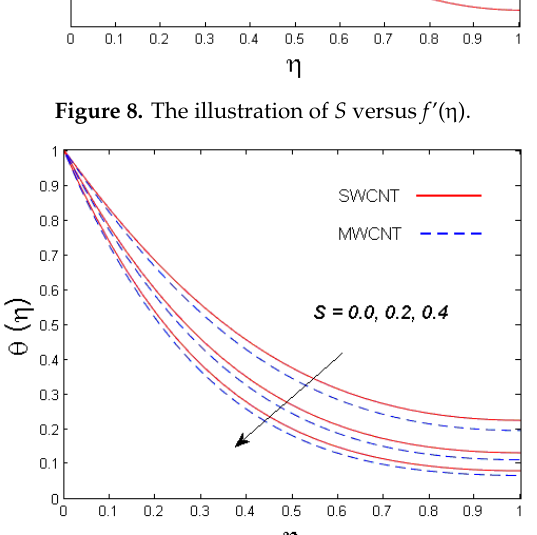
Figure 9. The illustration of S versus θ(η).